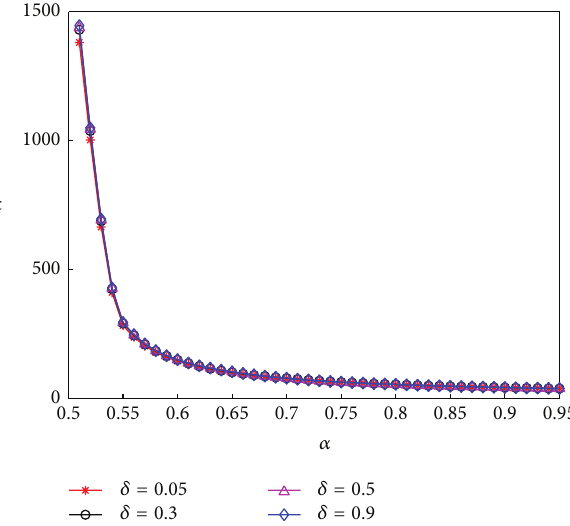
Figure 2: Correlation between 𝑘 and 𝛼 with given different 𝛿 .